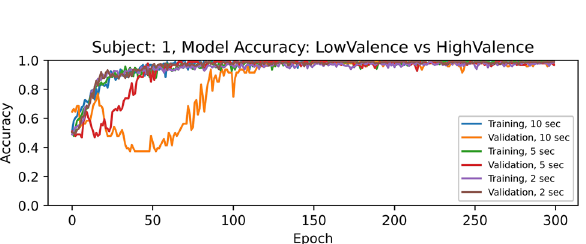
Figure 2. Accuracies for low valence vs high valence classification using segments of 10,5, and 2 s from all the EEG channels of subject 1.